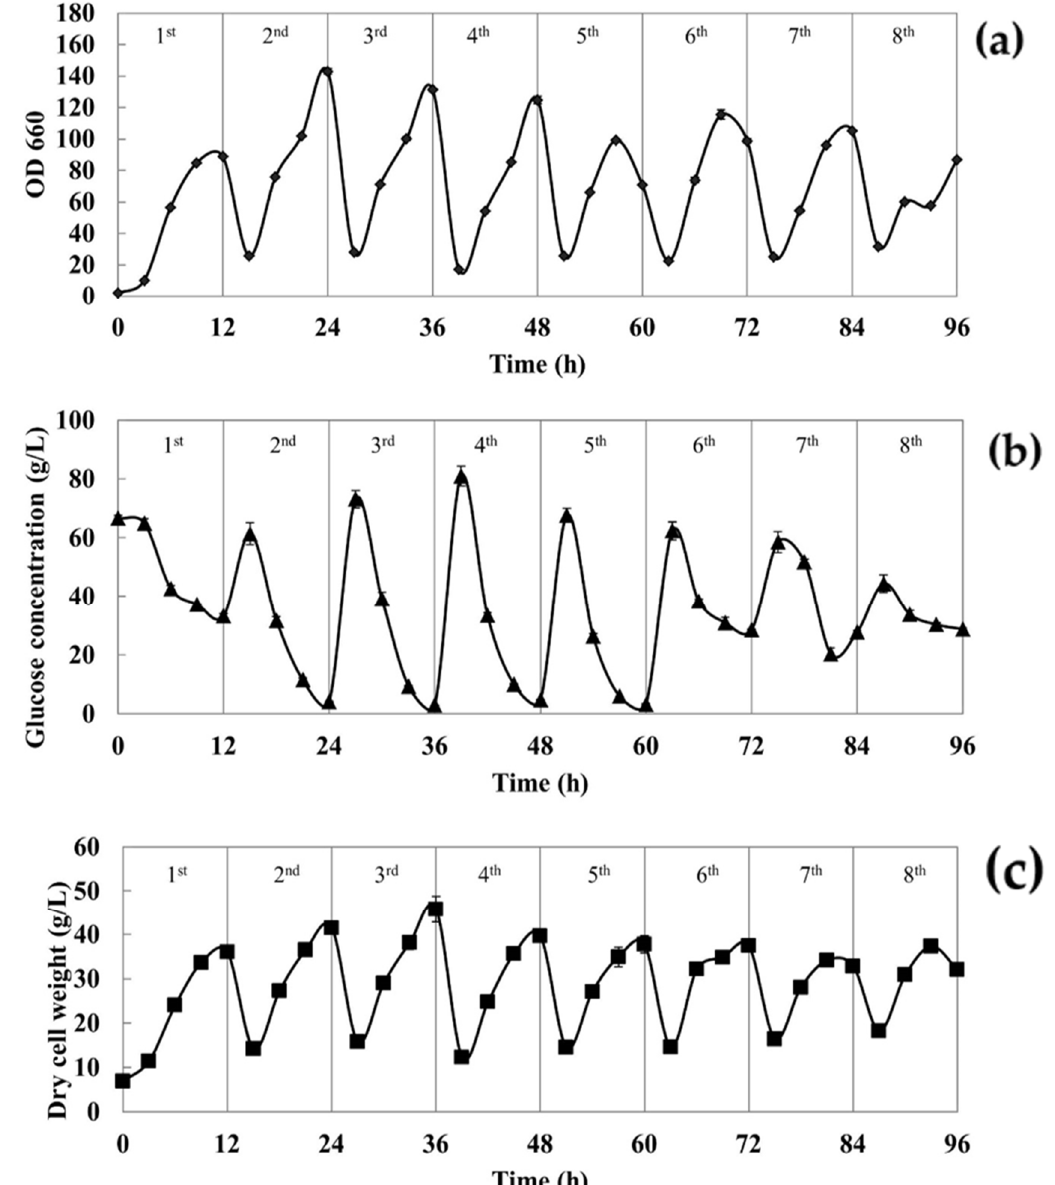
Figure 4. Changes in the optical density ( a ), glucose ( b ), and dry cell concentration ( c ) of K. marxianus SS106 in aerobically intensive multiple sequential batch simultaneous saccharification and cultivation using 100 g/L of liquefied starch as the substrate